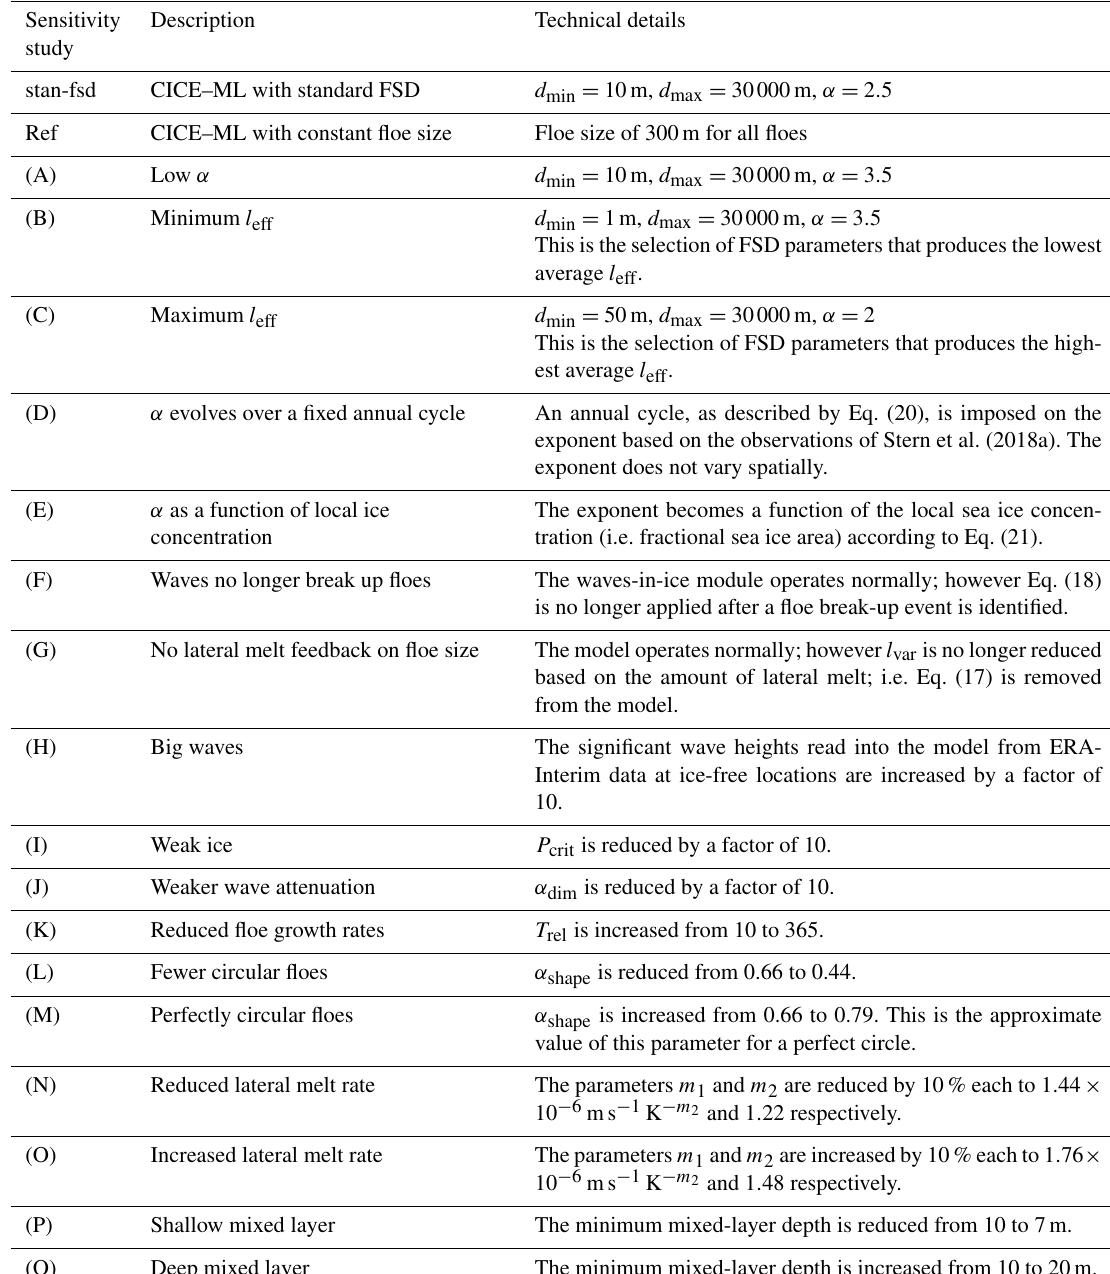
Table 2. The details of the sensitivity studies to explore the behaviour of the CICE–ML–WIPoFSD model. Parameters discussed here defined in Table